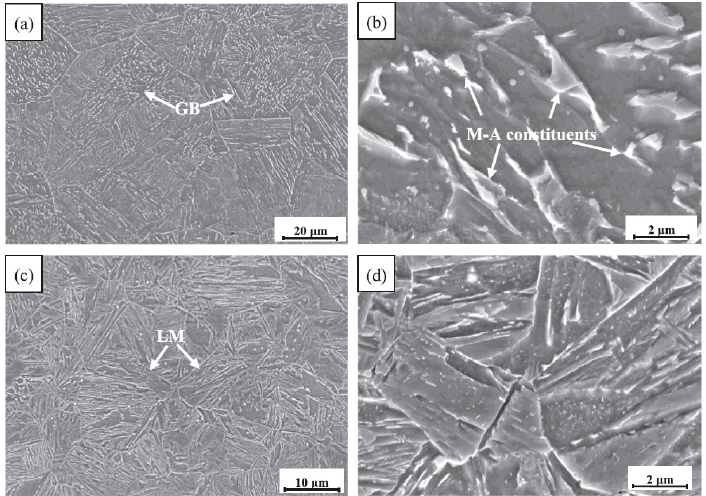
Figure 10. Microstructure of CGHAZ ( a , b ) GMAW and ( c , d ) LBW. Reprinted with permission from ref. [34]. Copyright 2016, Elsevier.